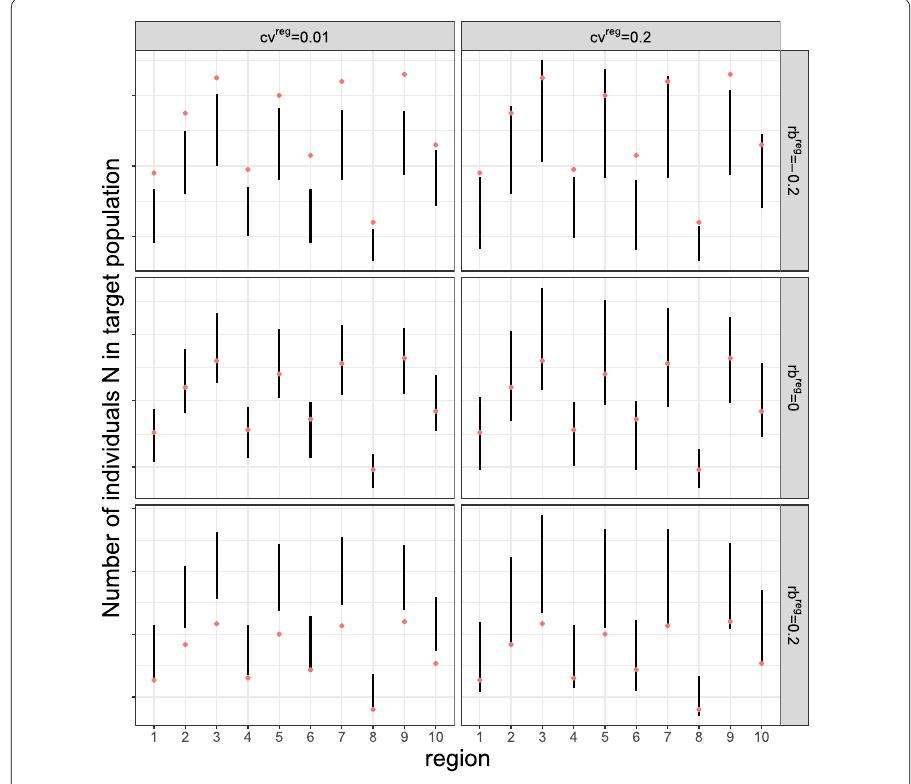
Figure 19 Credible intervals for the initial number of individuals N 0 per region. Credible intervals (prob = 95%) for the initial number of individuals N 0 per region compared to true values (in red) computed according to the whole module integration using the RSS geolocation model with uniform prior and the negative binomial state process inference model and different values of rb reg and cv